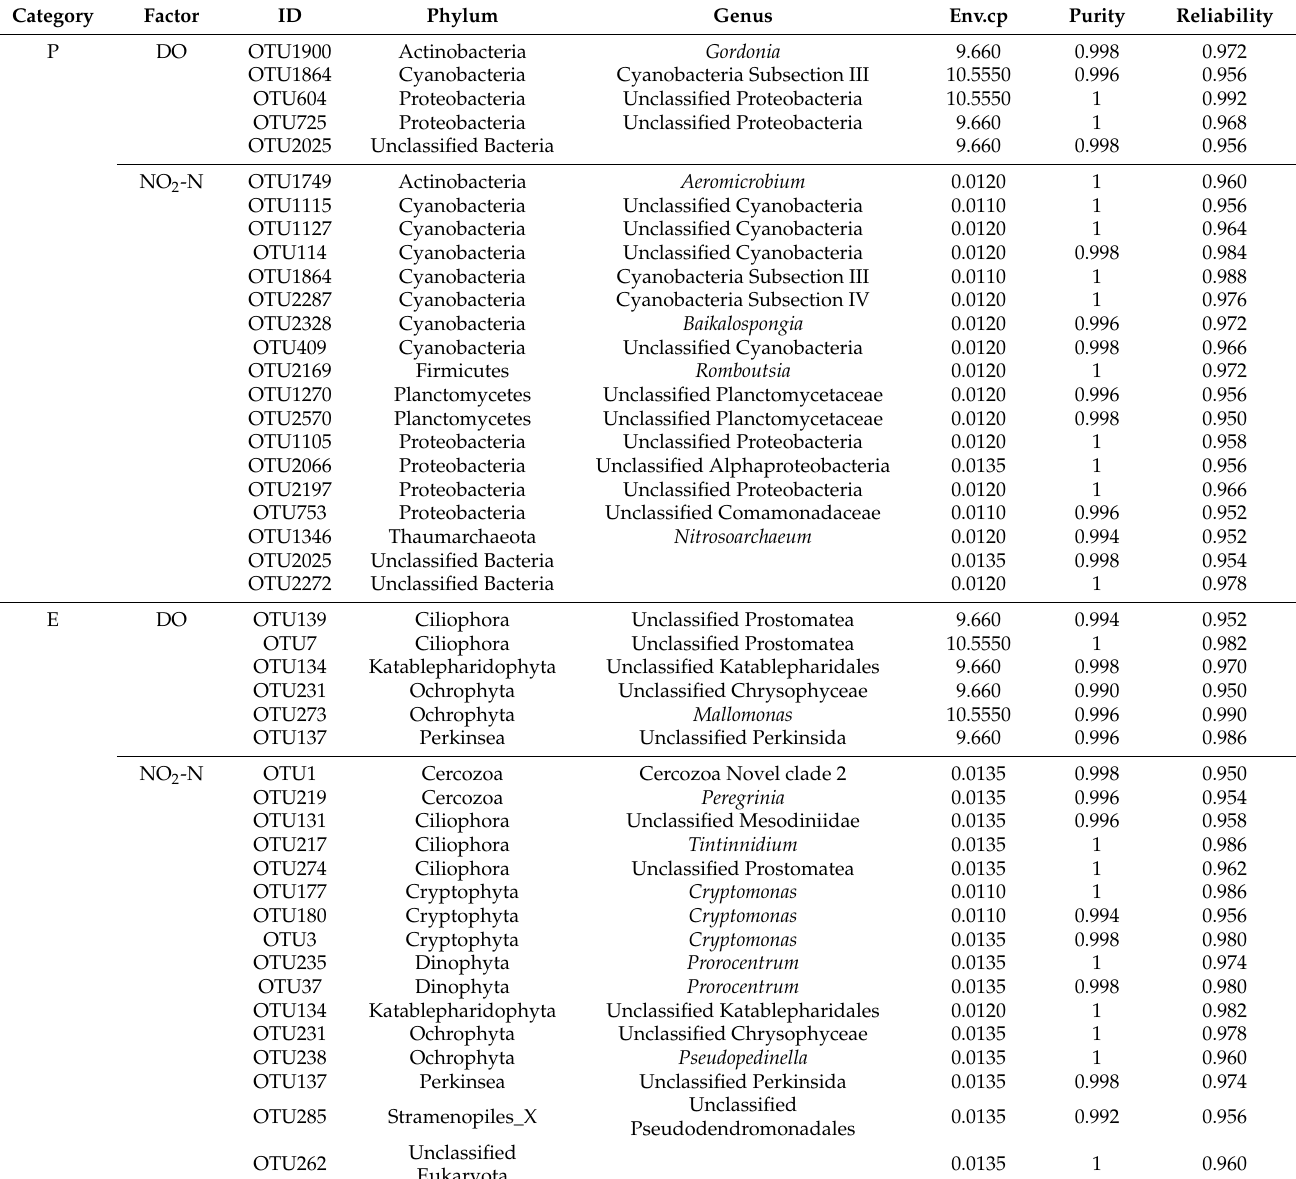
Table 4. Taxonomic assignment of indicator OTU from TITAN for prokaryotes and